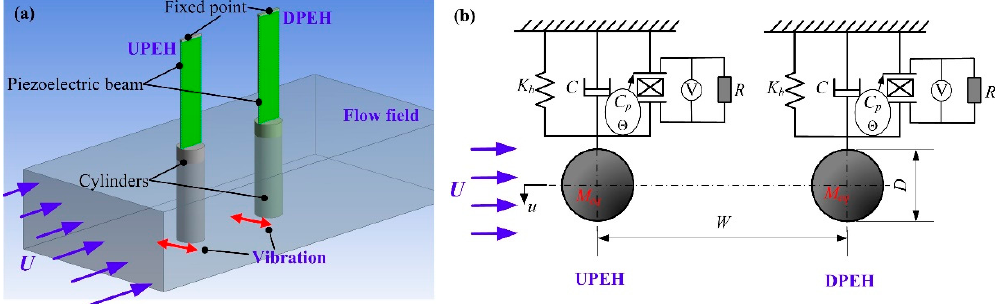
Figure 1. Schematic diagram of two tandem PEHs system: ( a ) three-dimensional system; ( b ) equivalent model of two tandem PEHs.